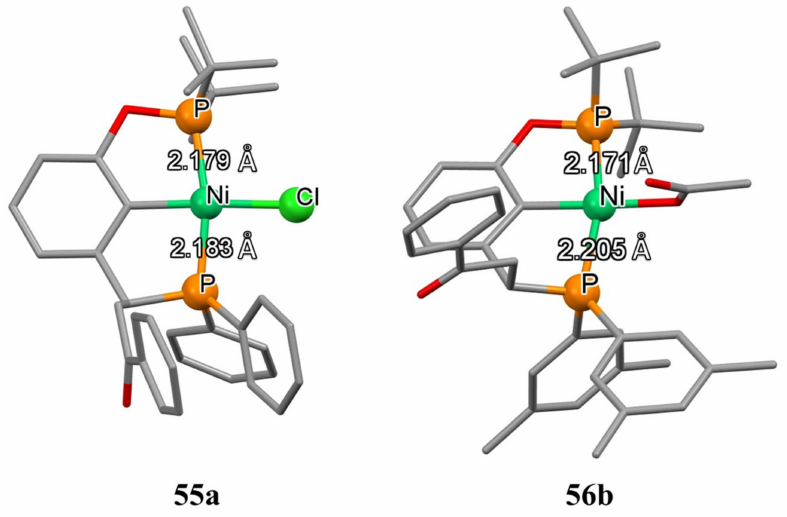
Figure 10. The structures of the unsymmetrical PCP (cid:48) nickel pincer complexes 55a , 56b